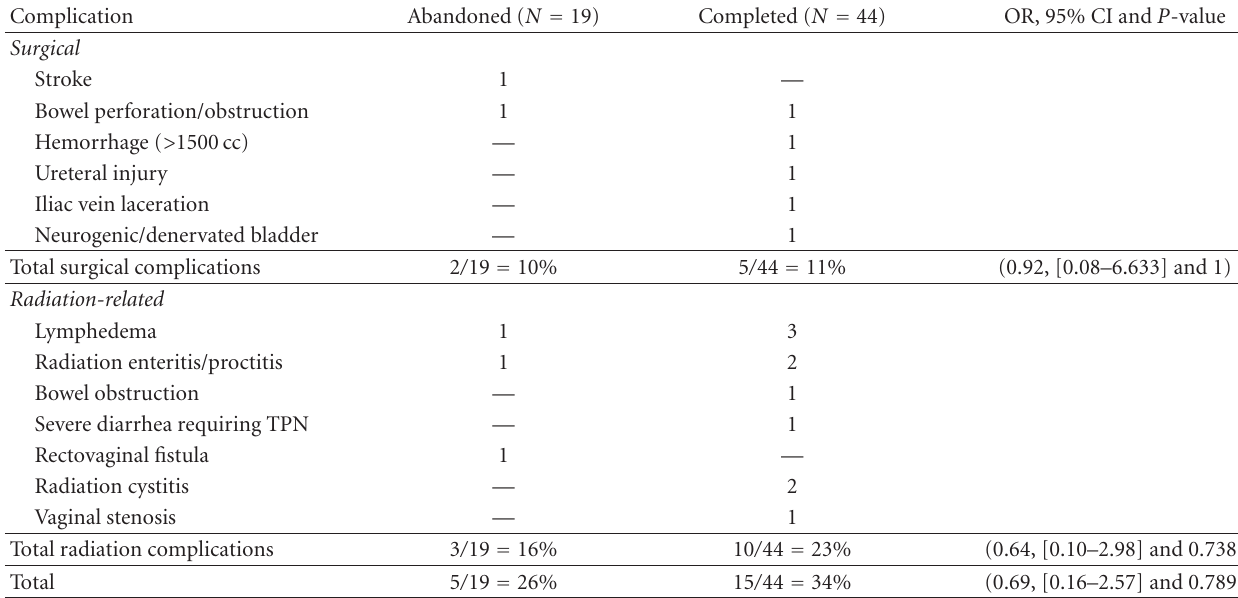
Table 2: Surgical-and radiation-related